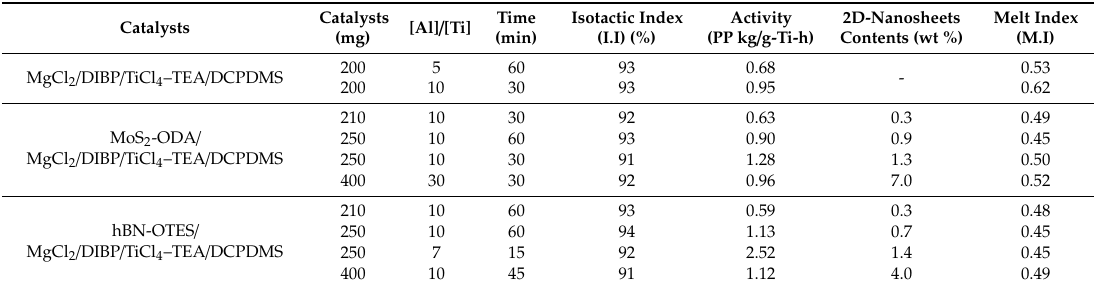
Table 1. Polymerization results of 2D-nanosheet / MgCl 2 -bisupported